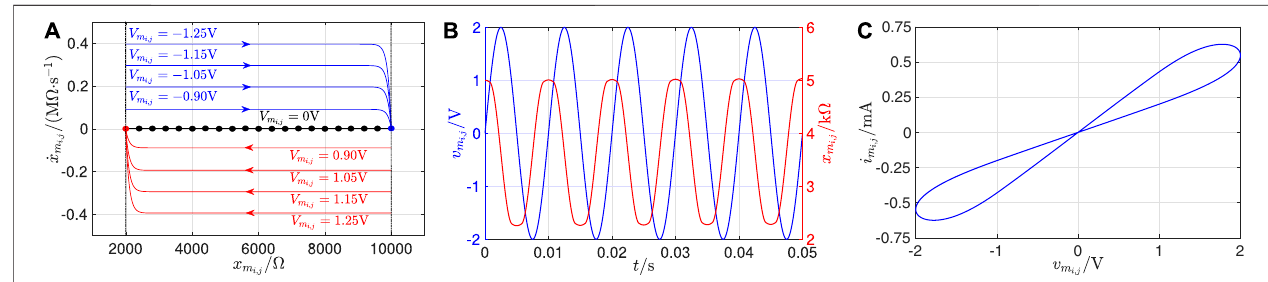
∈ { − 1 . 25 , − 1 . 15 , − 1 . 05 , − 0 . 90 , 0 , 0 . 90 , 1 . 05 , 1 . 15 , 1 . 25 } V. The blue (red) arrowed loci are FIGURE 10 | (A) SDRs foliating from the memristor DRM for V m (cid:5)(cid:5)(cid:5)(cid:5) (cid:5)(cid:5)(cid:5)(cid:5) i , j associatedtonegative(positive)valuesforthememristorvoltage.Inthe fi rst(latter)case,thelargeris ,andthehigheristhespeedofthememristorstateinitsmotion V m i , j (cid:1) x toward the equilibrium x m off ( on ) . The black locus represents the memristor POP. (B) Proof of evidence for the analogue dynamic response of the memristor state, i , j (cid:1) (cid:13) v · sin ( 2 · π · f · t ) , with amplitude (cid:13) v (cid:1) 2V and frequency f (cid:1) 100Hz, appearing between hosted by the cell C ( i , j ) , to a sinusoidal voltage of the form v m m i , j m i , j m i , j m i , j i , j – i itsterminals. (C) Pinchedhysteresisloopemergingonthe v m m i , j planeasaresultofthedeviceperiodicexcitationillustratedin (B) .Thememristormodelparametersare i , j set as follows: α (cid:1) 10 5 Ω · V − 1 s − 1 , β (cid:1) 10 6 Ω · V − 1 s − 1 , V t (cid:1) 0 . 95V, p (cid:1) 40, x on (cid:1) 2k Ω , x off (cid:1) 10k Ω